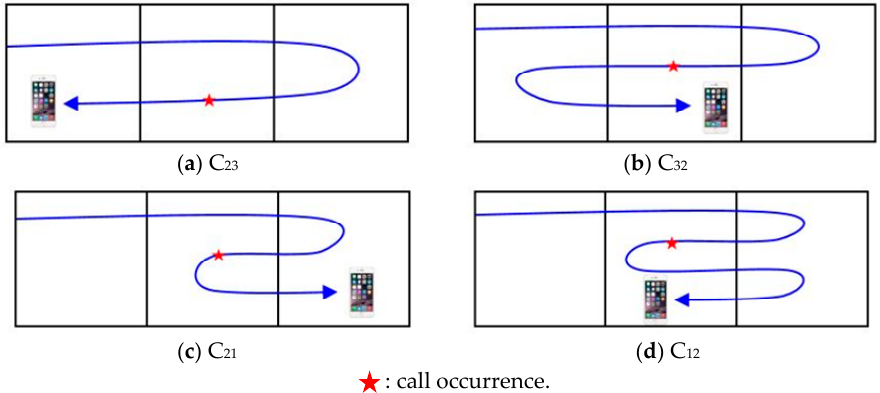
Figure 7. Examples of states C ij . : ( a ) C 23 ; ( b ) C 32 ; ( c ) C 21 ; ( d ) C 12.